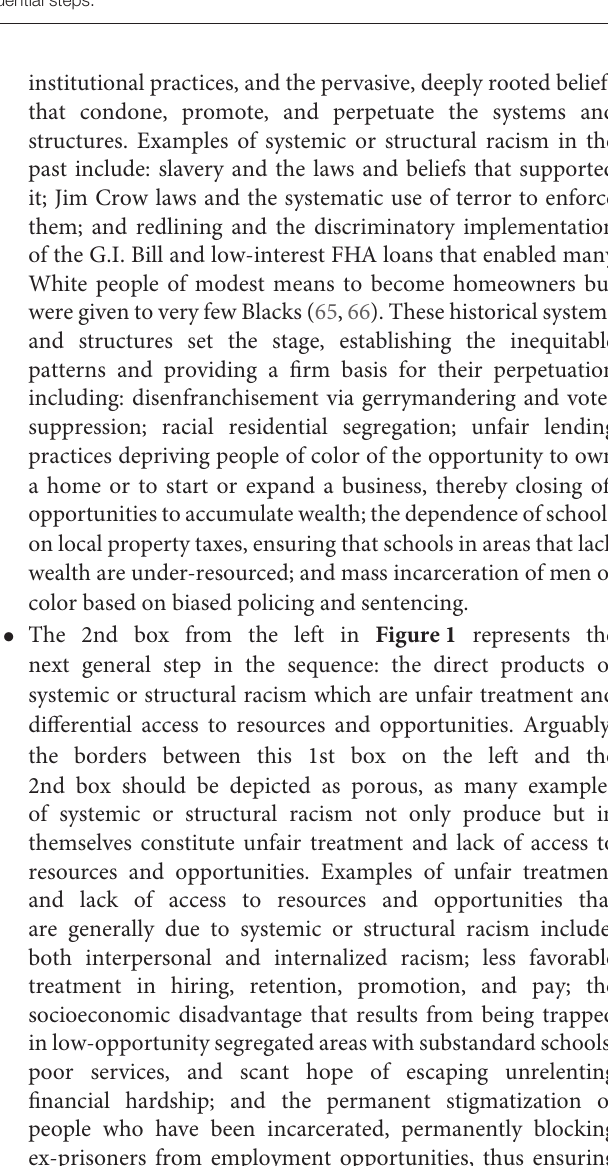
FIGURE 1 | How racism is thought to damage health: a general overview of key sequential